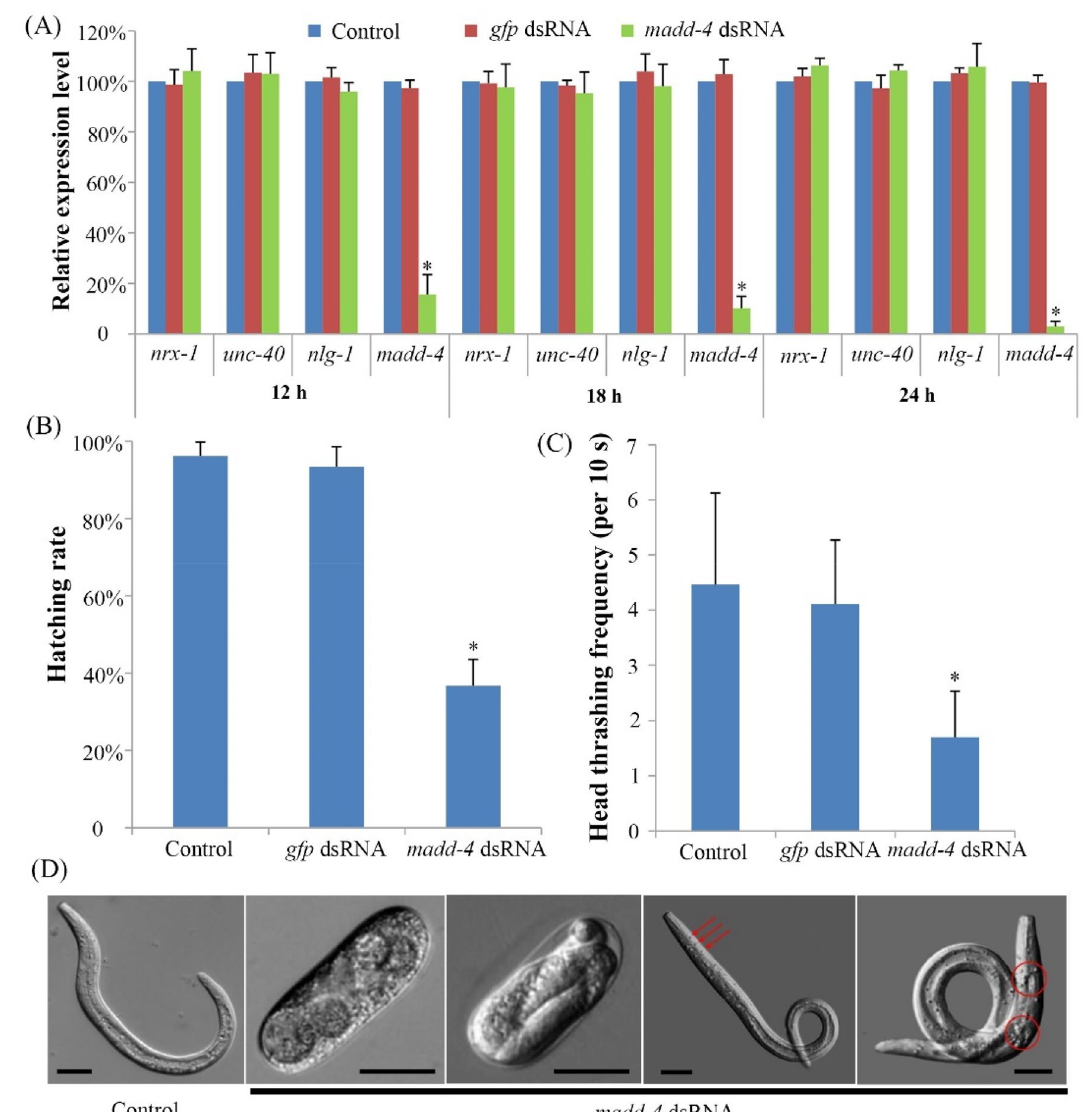
Figure 8. Teratogenic effects of madd-4 knockdown in B. xylophilus . ( A ) mRNA expression levels of madd-4 , three potential upstream or downstream genes, nrx-1 , unc-40 , and nlg-1 in B. xylophilus after RNAi treatment for 12 h, 18 h, and 24 h, respectively. RT-qPCR reactions were performed in triplicate. ( B ) The percentage of hatched embryos in B. xylophilus after RNAi treatment for 24 h. ( C ) The number of head thrash per 10 s was recorded to assess the motility of the J2 in B. xylophilus after RNAi treatment for 24 h. ( D ) Pictures represented arrested development of embryos and abnormal of J2 in B. xylophilus after RNAi treatment for 24 h. Error bars show standard errors. The asterisks show a significant difference (p < 0.05) between the treatments and the controls. Scale bar, 20